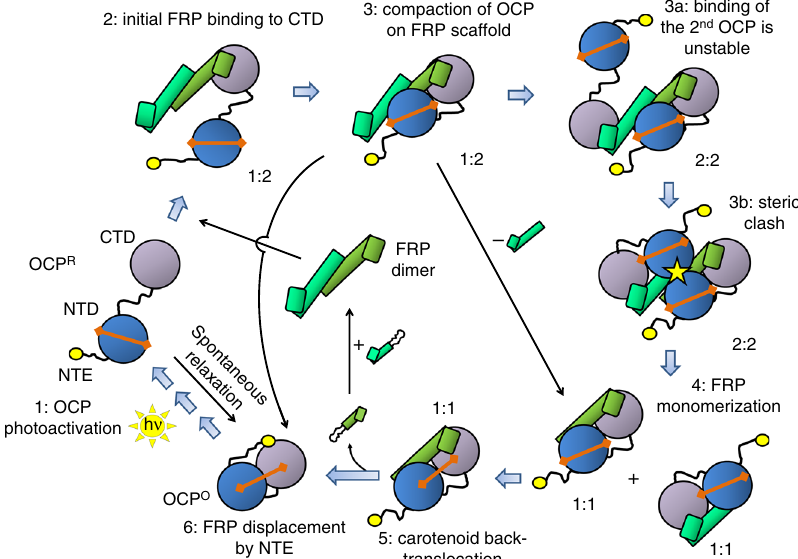
Fig. 8 Proposed mechanism of the FRP scaffold terminating OCP-mediated photoprotection in cyanobacteria. Stages of the process are numbered from 1 to 6 and described in the text. The proteins are color-coded as in Fig. 5d, the carotenoid is shown as an orange dumbbell. OCP photoactivation is depicted by sun symbol. Yellow circle designates NTE. Individual FRP monomers are shown partially unfolded. Stoichiometry of the heterocomplexes formed between OCP and FRP are indicated. The yellow star designates the tentative clash between two bound OCP molecules destabilizing OCP – FRP complexes